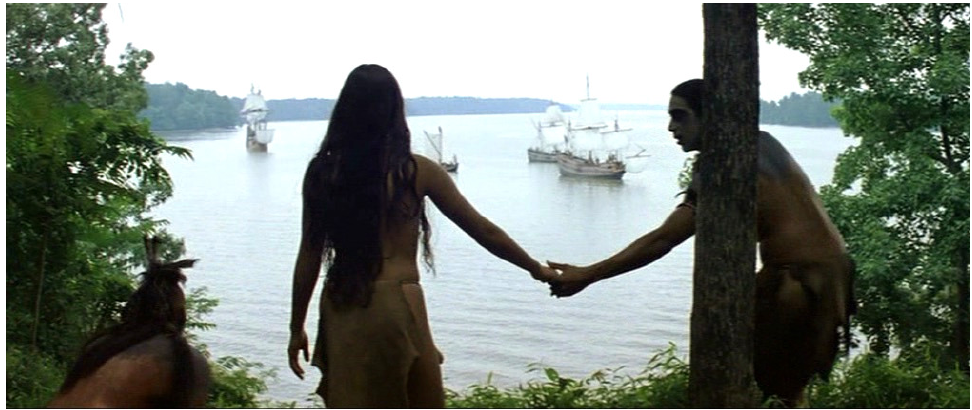
Figure 1: Pocahontas witnesses the Colonists’ arrival: her openness contrasts with her brother’s cautious reticence. A future choice is prefigured in the